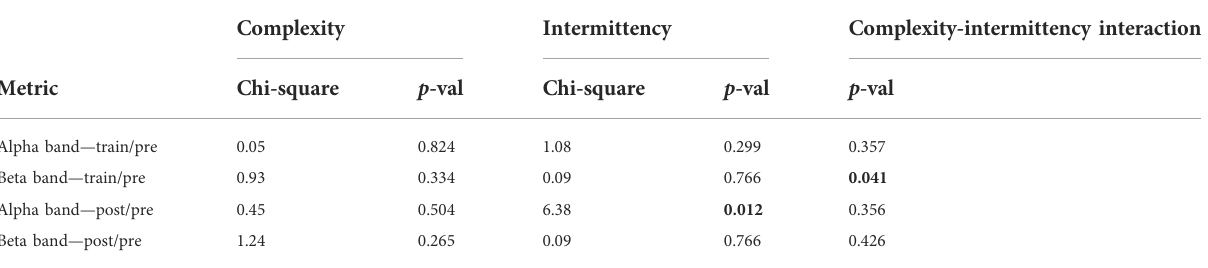
Table 3B: Two-way ANOVA results based on factors of complexity and intermittency